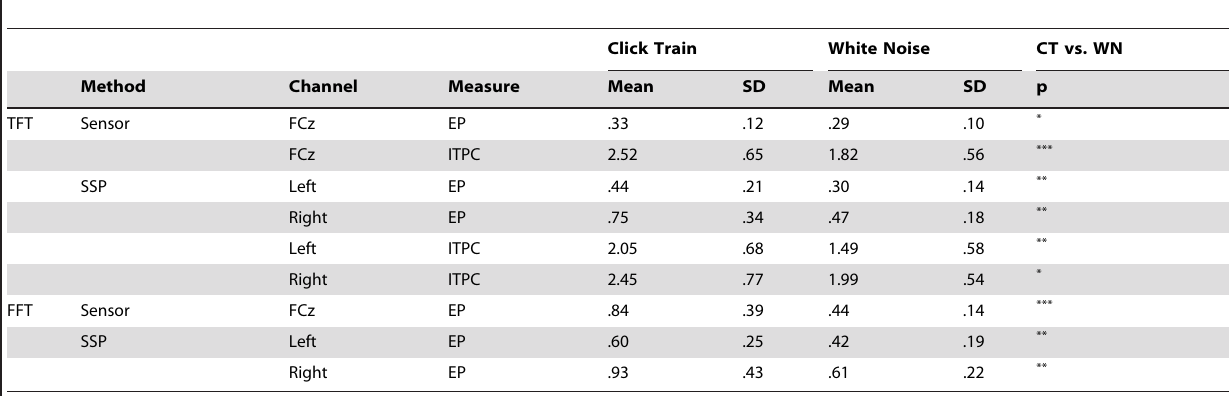
CT= click train; WN= white noise; SD= standard deviation; TFT= time-frequency transformed data; FFT= Fast Fourier transformed data; ITPC= inter-trial phase coherence; SSP= signal-space projection; EP= evoked power (absolute). Significant left vs. right hemisphere comparisons: TFT SSP EP (click train***; white noise*); TFT